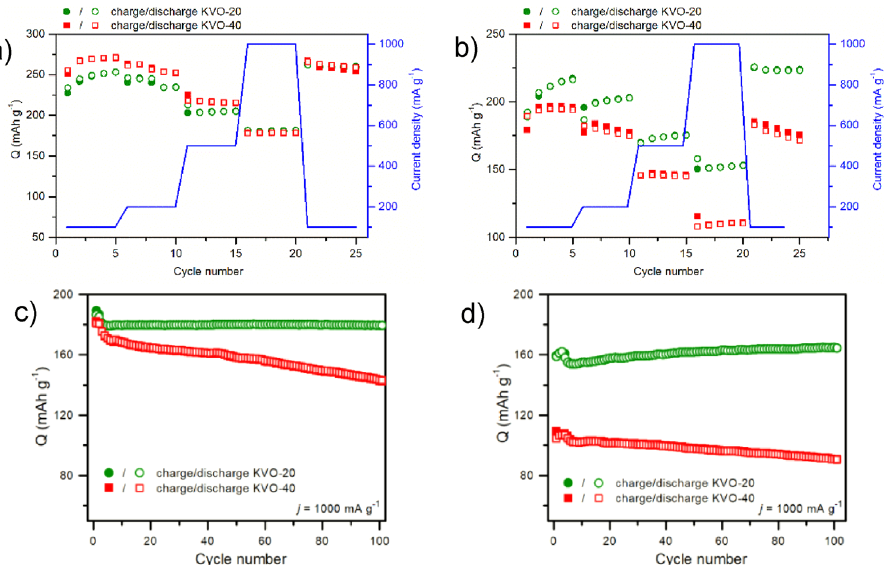
Figure 4. Electrochemical performance of KVO-20 and KVO-40 electrode materials: Galvanostatic tests over the voltage range of ( a ) 1.5–4.0 V and ( b ) 2.0–4.0 V. The charge/discharge tests at j = 1 A g −1 for 100 cycles in ( c ) 1.5-4 V and ( d ) 2.0–4